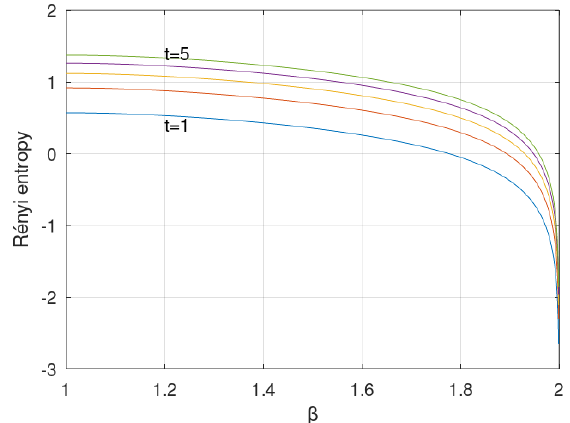
Figure 4. Rényi entropy as function of β ∈ ( 1,1.99 ) for t = 1,2, · · ·